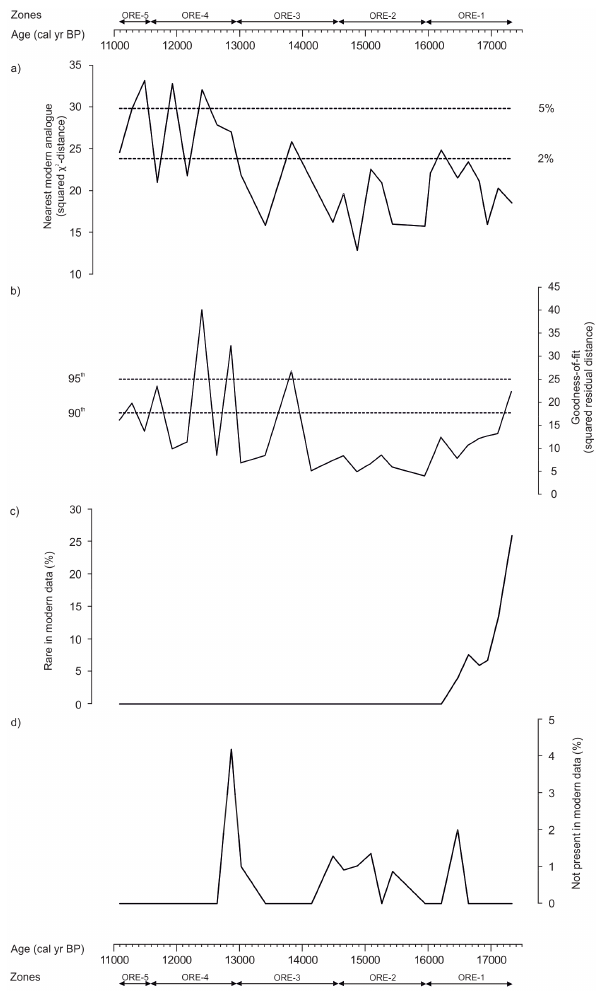
Fig. 5. Diagnostic statistics of the chironomid-inferred July tem- perature reconstruction for the Origlio record (a–d) . (a) Mod- ern analogues for the fossil samples in the calibration data set; (b) goodness-of-fit statistics of the fossil samples with tempera- tures; (c) percentage of rare chironomid head capsules (N2 < 5); (d) chironomid taxa not represented in the calibration set. Hori- zontal dashed lines are used to identify samples with “no close” (2%) and “no good” (5%) modern analogues, and samples with “poor” (90th percentile) and “very poor fit” (95th percentile) with